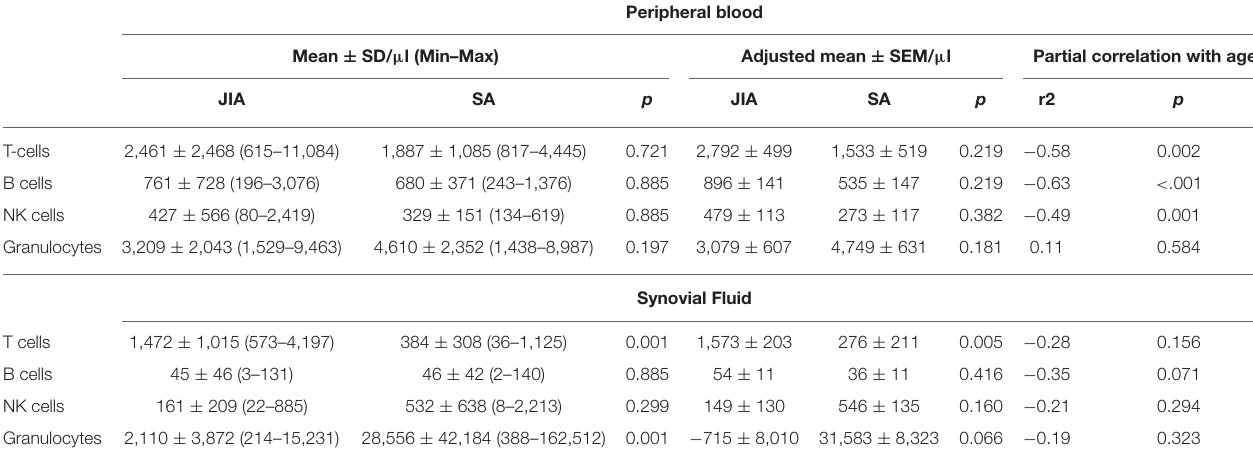
TABLE 2 | Immune cell counts in peripheral blood and synovial fluid